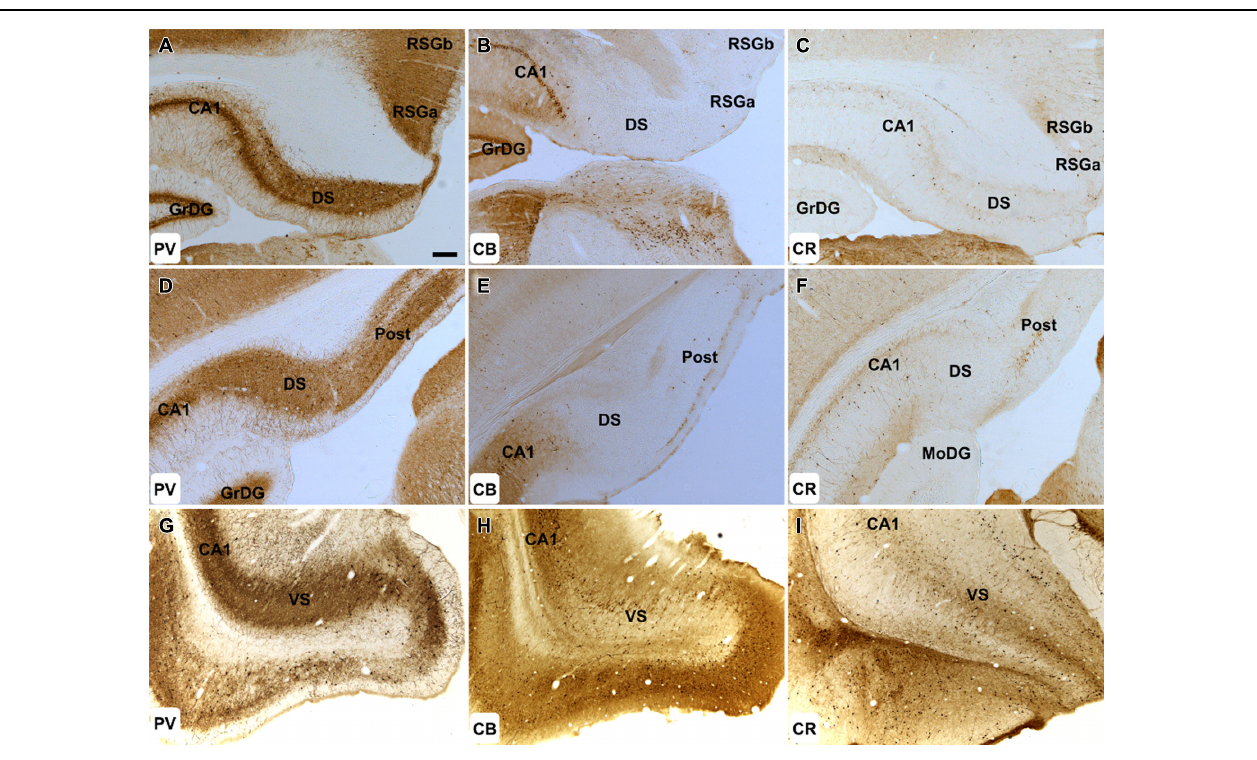
FIGURE 3 | Hippocampal formation: (A–C) 50 × magnification photomicrographs of PV (A,D,G), CB (B,E,H), and CR (C,F,I) immunoreactivity in coronal sections of the rat cerebrum. Cellular and neuropillar PV label was present throughout the DS, VS, and post. CB immunoreactivity was virtually absent within these structures. While only sparsely distributed CR immunoreactive cells were found in the DS, the